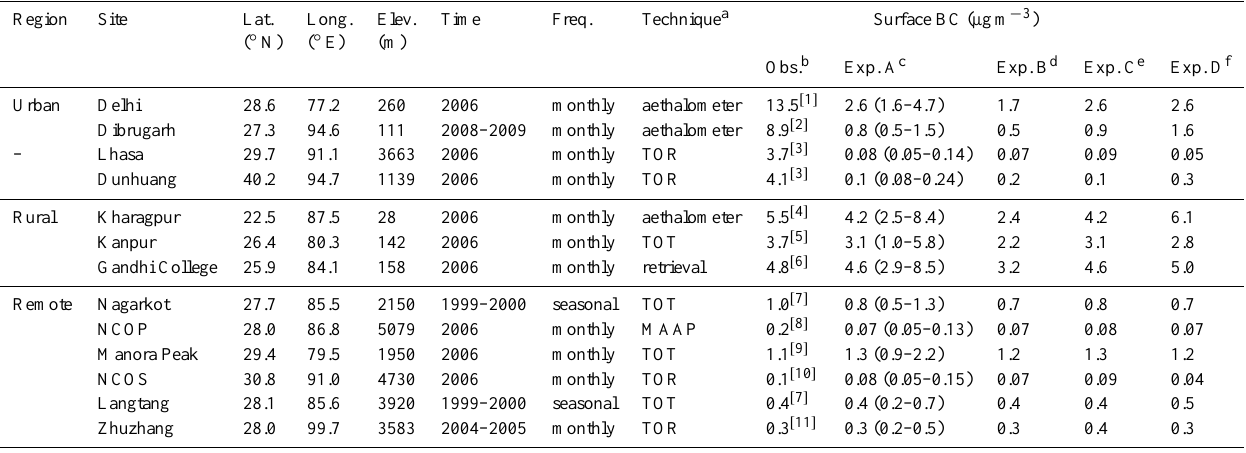
Table 1. Observed and simulated surface-BC concentrations over the Tibetan Plateau (see also Fig. 1). Region Site Lat. Long. Elev. Time Freq. Technique a Surface BC (µgm − 3 ) ( ◦ N) ( ◦ E) (m) Obs. b Exp. A c Exp. B d